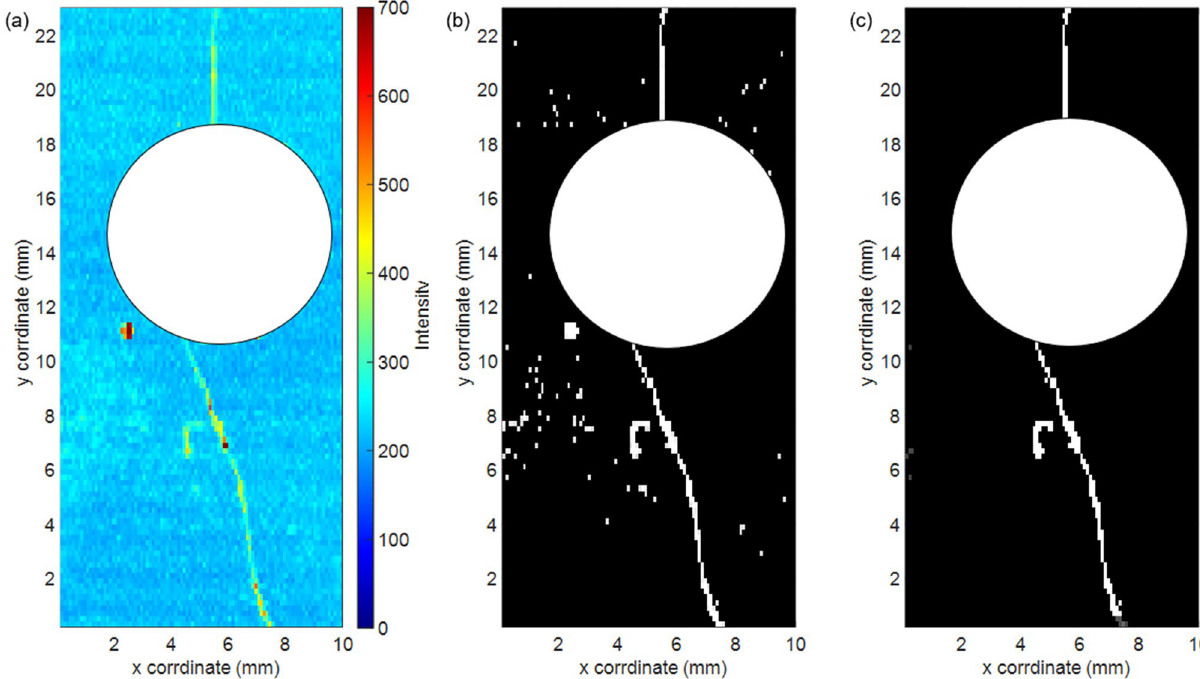
Figure 6. ( a ) Maximum intensity map of the fluorescence emission from the painted cement surface; ( b ) detected cracks after single thresholding; ( c ) detected cracks after hysteresis thresholding, as described in the